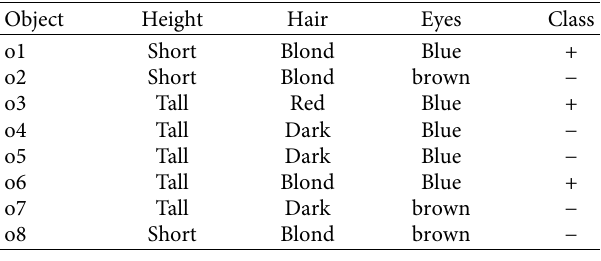
Table 1: An information